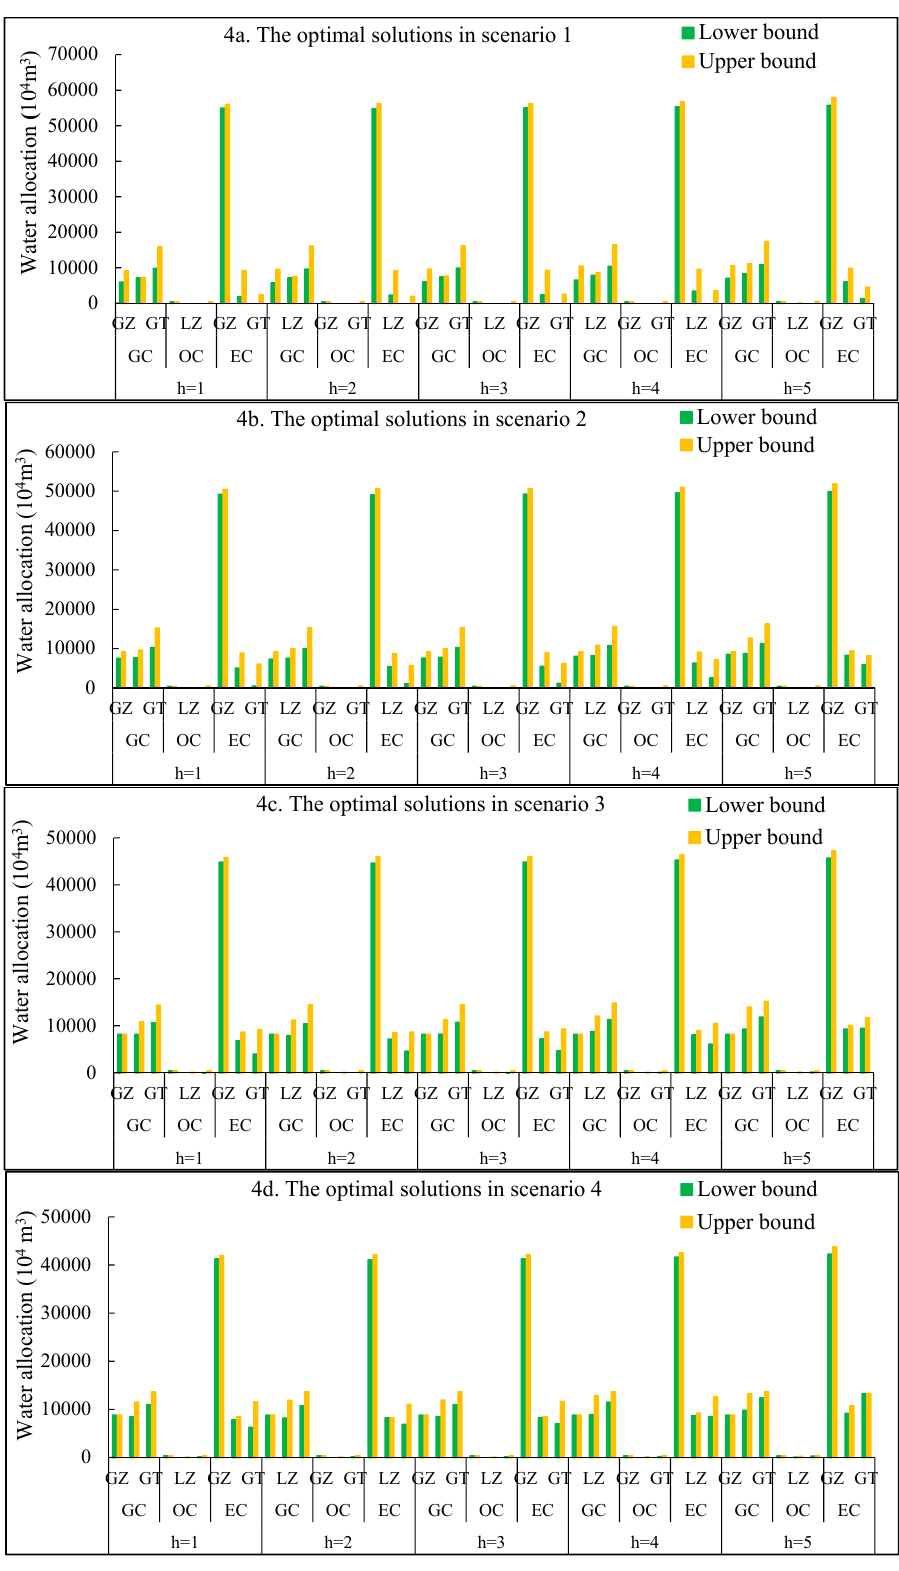
Figure 4. Comparison of results in di ff erent scenarios and di ff erent inflow levels based on the improved plan. ( a ) The optimal solutions in scenario 1; ( b ) The optimal solutions in scenario 2; ( c ) The optimal solutions in scenario 3; ( d ) The optimal solutions in scenario